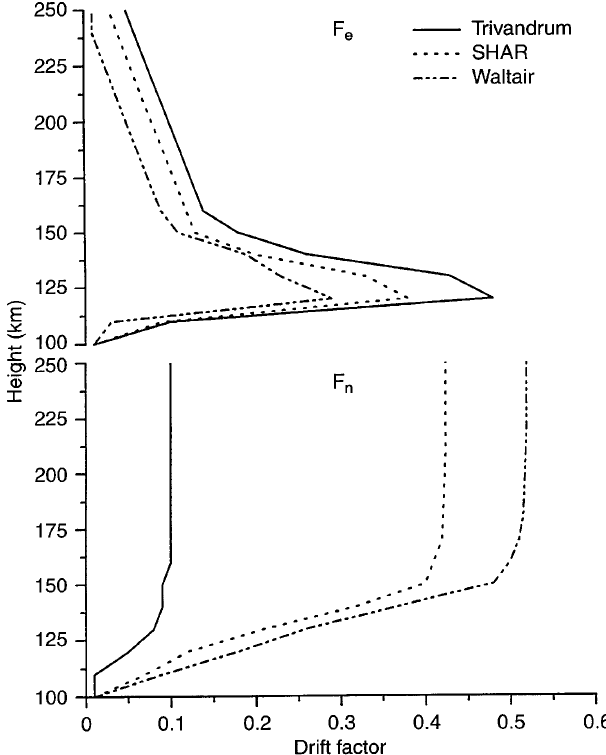
Fig. 7. Drift factors calculated using the method by MacDougall (1972) for the three stations